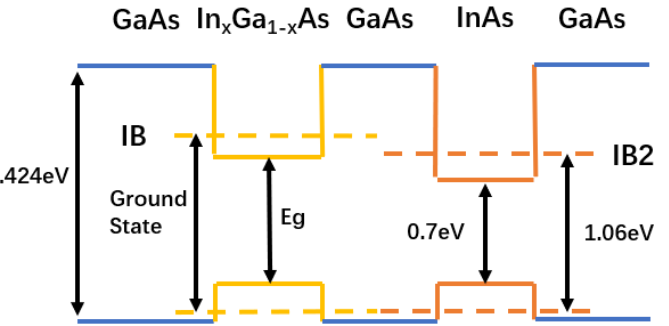
Figure 4. Dual intermediate band structure for the InAs/GaAs/In x Ga 1 − x As QDs system.